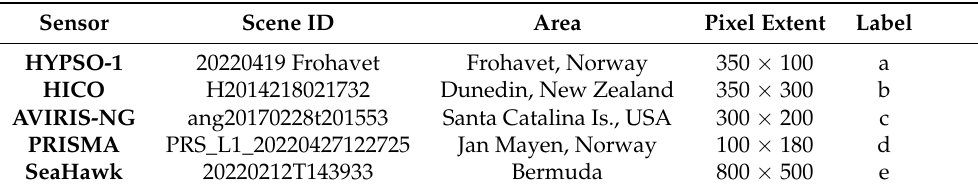
Table 9. The sensor and accompanying scene identification string alongside the area name of the scenes used for SNR estimation. The Pixel Extent is the spatial picture element dimensions of the homogeneous area. The label column corresponds with Figure 14. Sensor Scene ID Area Pixel Extent Label HYPSO-1 20220419